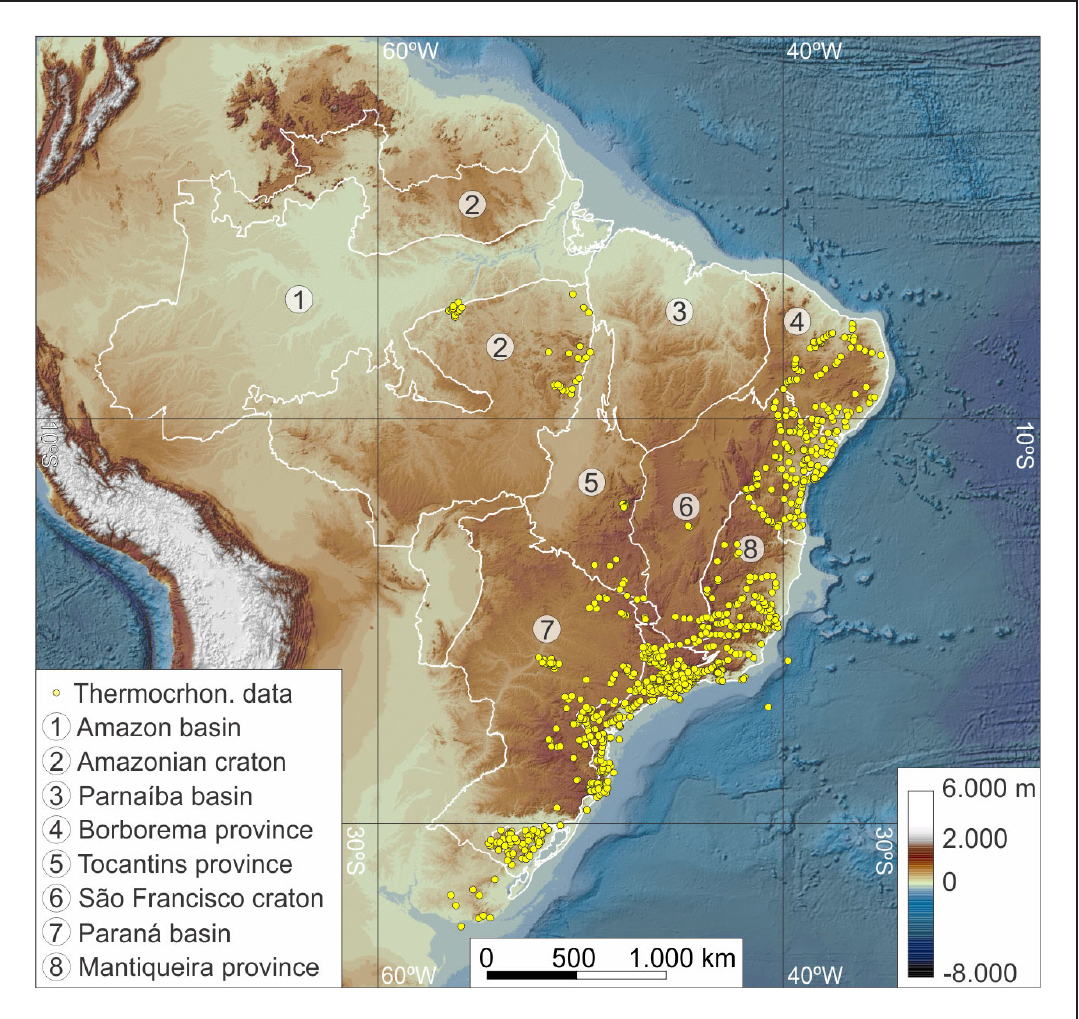
FIGURE 2 . Thermochronological data set available for Brazil. The white lines divide the different geotectonic domains (1 to